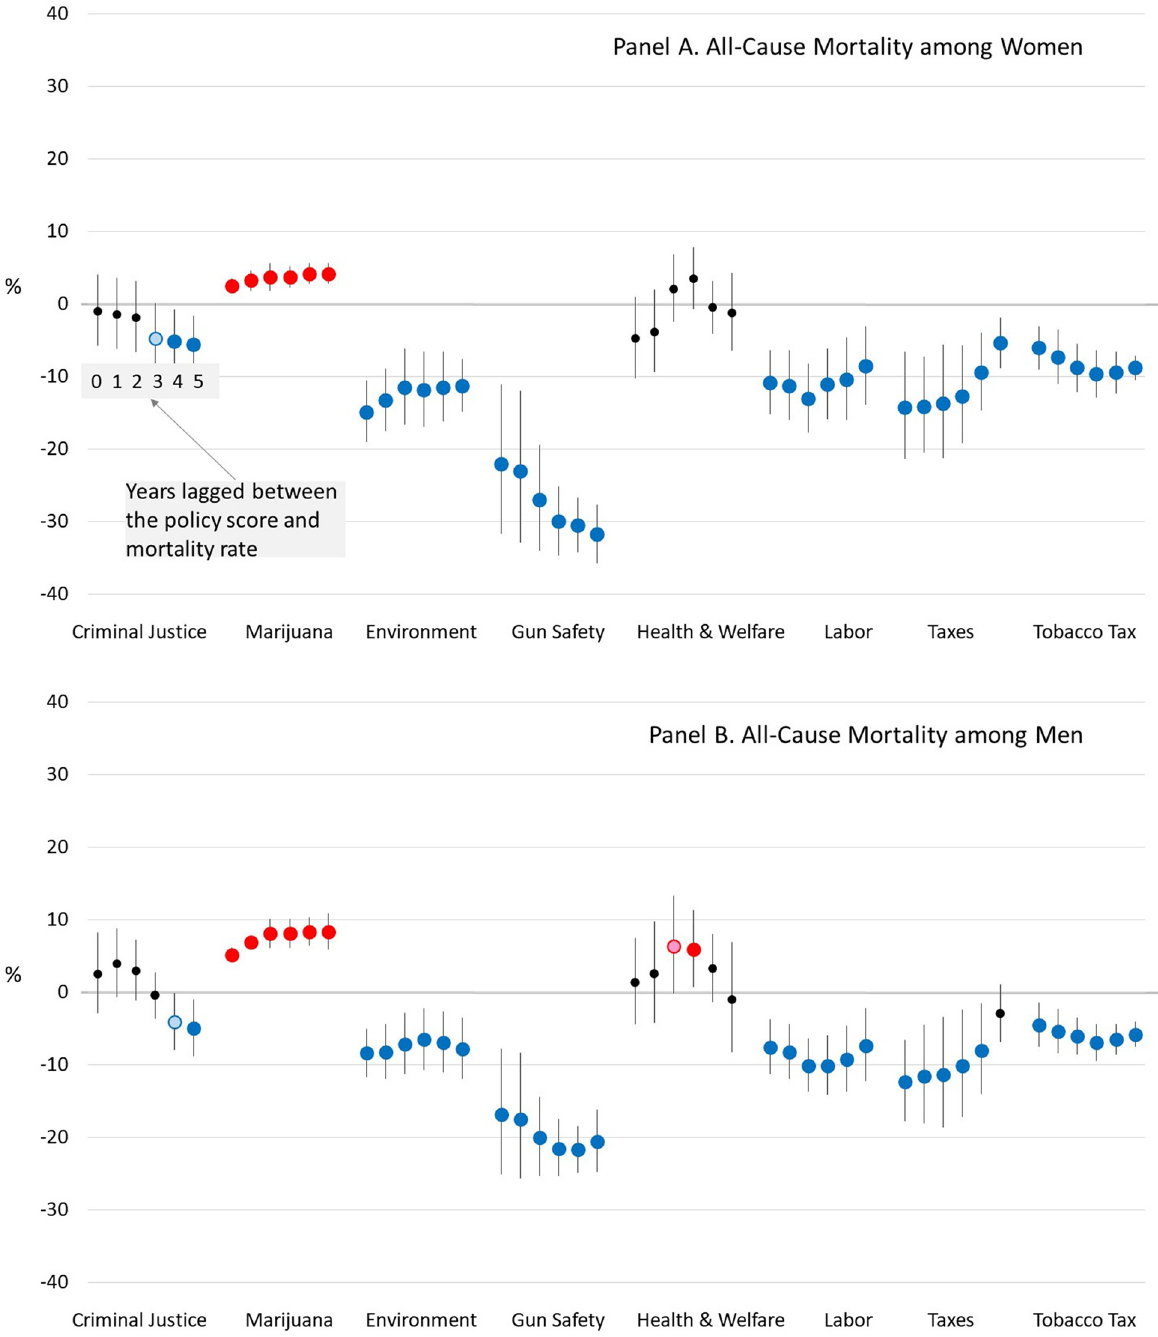
Fig 2. Estimated percent difference in all-cause mortality rates when a U.S. State’s policy liberalism score is 1 versus 0, for various lag times between the policies and mortality. Notes : Blue dots mean a more liberal version of the policy is associated with lower mortality and red dots mean a more conservative version is associated with lower mortality. Dark blue and red dots indicate that the association is significant at α < 0.05, while light blue and red dots indicate that it is significant at α < 0.10.